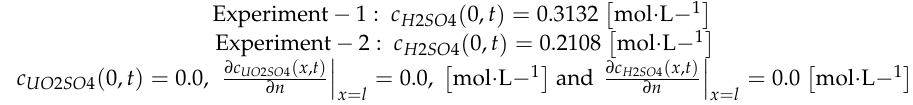
(cid:104) (cid:105) mol · L − 1